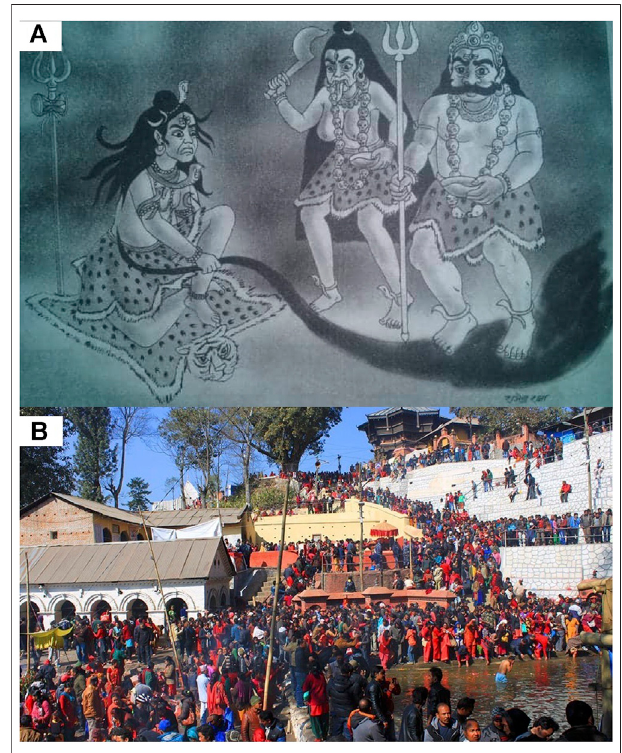
FIGURE 1 | Showing the power of the God Shiva and Goddess Swasthani. (A) An illustration showing God Shiva while creating two Gods, Mahankali and Veerbhadra , byplucking two ofhis hairs, throwing them on the ground and making the earth to tremble (Swasthani, 2020: 69). (B) A picture of Nepali women at the Goddess Swasthani temple in Kathmandu waiting for worship (photo credit: Nakarmi, 2019).